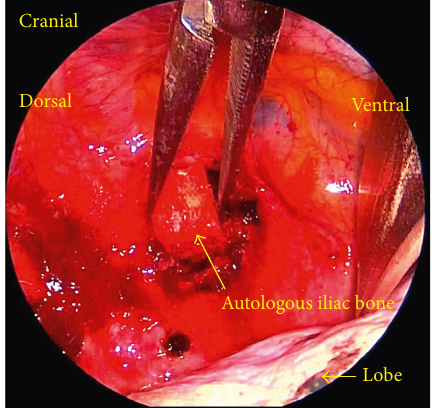
Figure 3: Anterior debridement and interbody fusion at T2/3 were performed using a video-assisted operating